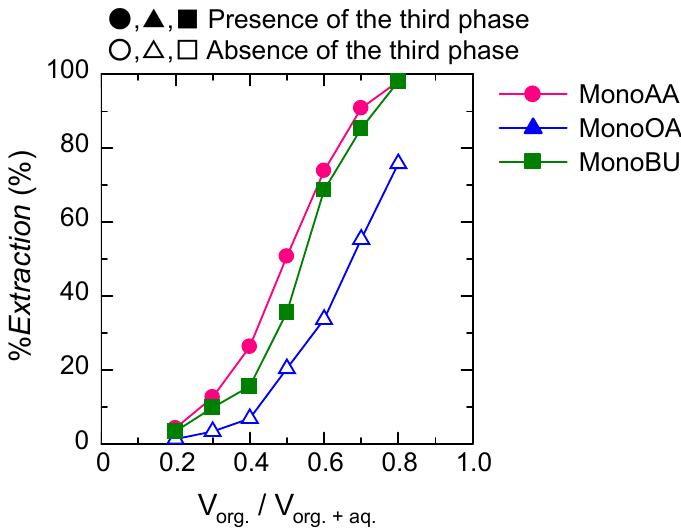
Figure 6. Effect of phase ratio between organic and aqueous phases on the extraction percentage of Pt(IV) by MonoAA, MonoOA, and MonoBU. [Extractant] org,i = 1.0 M in n -dodecane/2-ethylhexanol (80 vol%/20 vol%), [Pt(IV)] aq,i = 0.281 M, [Ir(III)] aq,i = 9.64 × 10 − 3 M, [Rh(III)] aq,i = 0.116 M, [Cu(II)] aq,i = 0.262 M, [HCl] aq,i = 2.0 M, V org :V aq = 2:8 − 8:2.